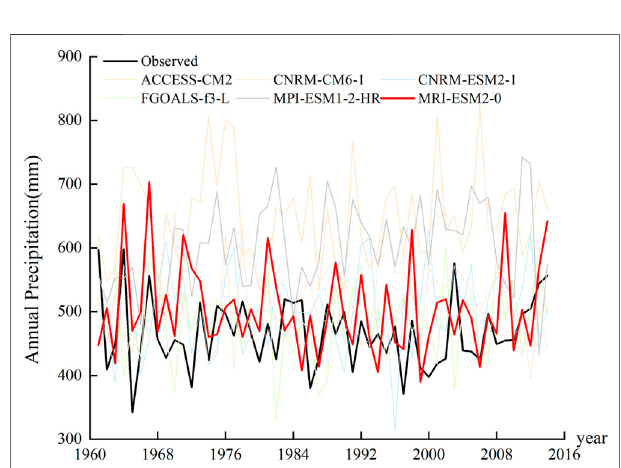
FIGURE 4 | Annual precipitation of the six higher-scoring GCMs and the observed data. The red line denotes the GCM with the highest score in the comprehensive